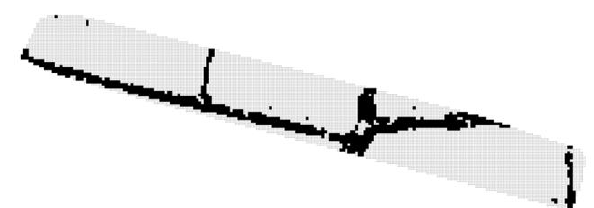
Figure 15. The skeleton for Block 3 obtained after the combined analysis of the two segmentations